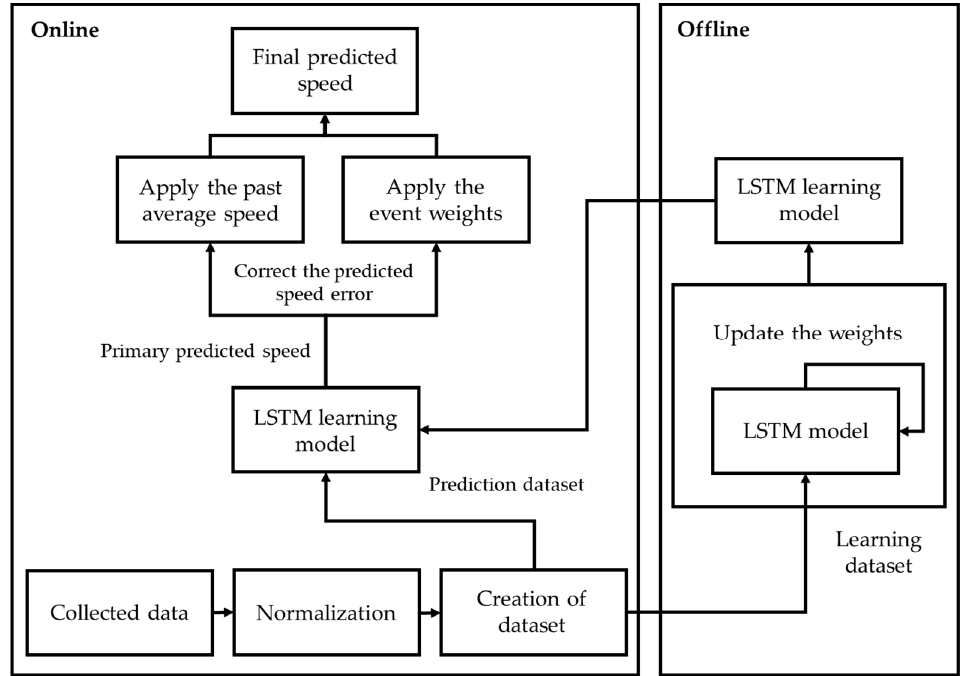
Figure 4. Overall structure of the proposed road speed prediction scheme.